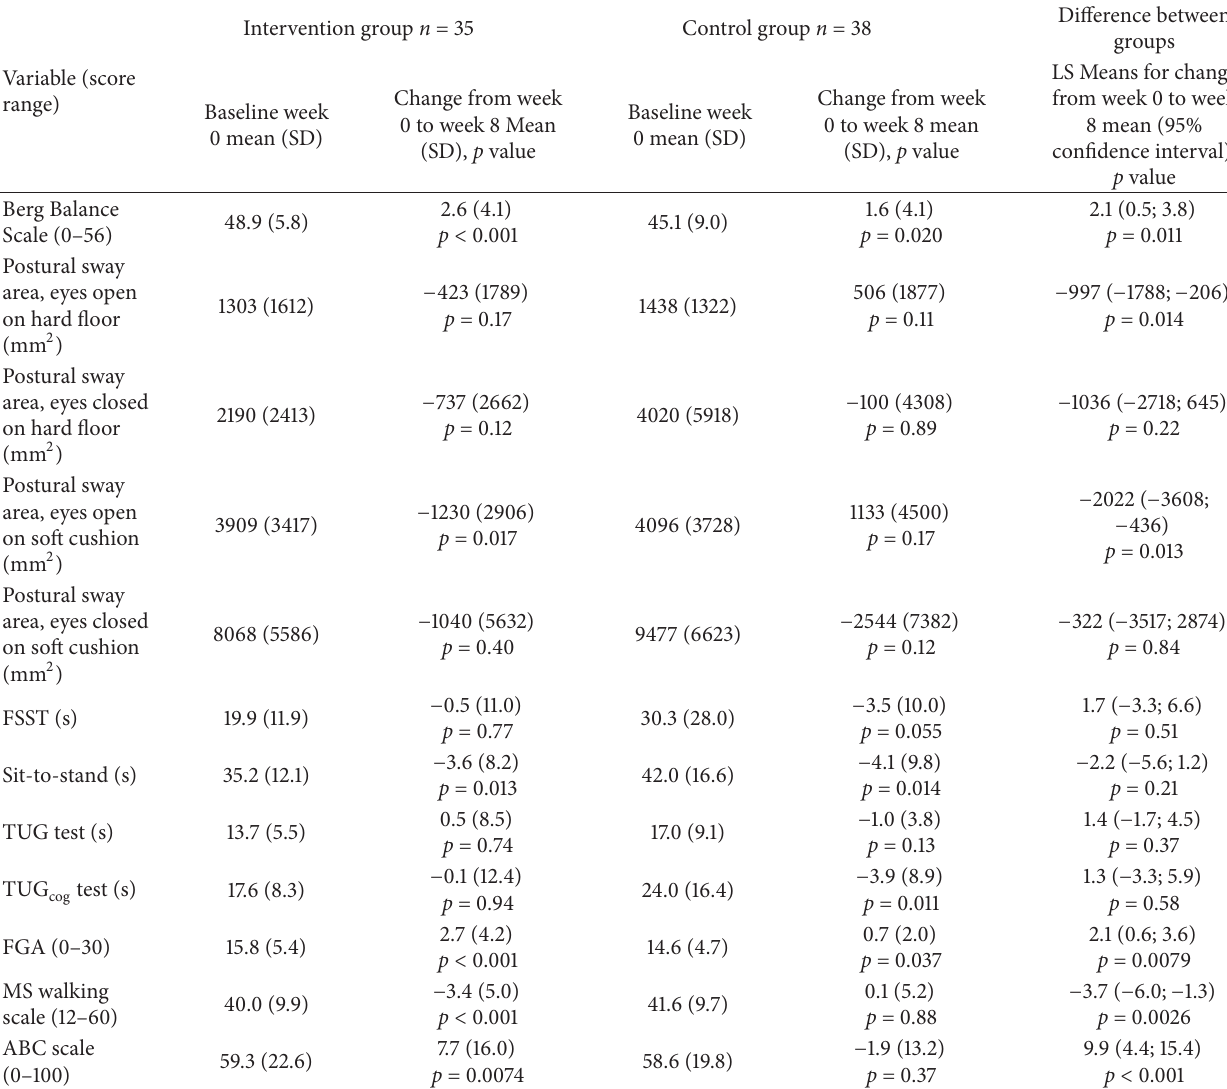
Table 2: Results on the outcome measures at baseline and postintervention (week 8) assessments, change from baseline, and differences between